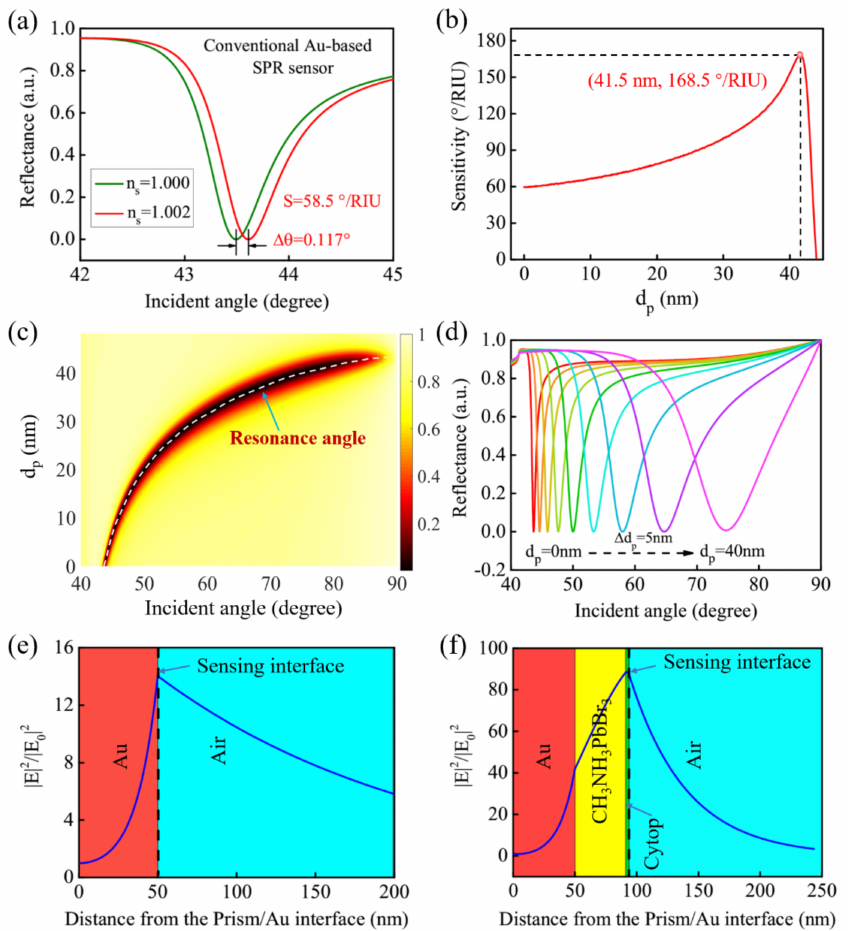
Figure 7. ( a ) SPR signal excited from the conventional SPR gas sensor, and the sensitivity is calculated to be 58.5 ◦ /RIU. ( b ) The sensitivity curve corresponding to different thicknesses of d p for the proposed GWSPR gas sensor, and the highest sensitivity (168.5 ◦ /RIU) is obtained at d p = 41.5 nm. ( c ) The movement of resonance angle corresponding to different thickness of d p . ( d ) The resonance signals excited from the proposed GWSPR gas sensor at different d p . ( e , f ) The electric field distributions of the conventional SPR gas sensor and the new Au-CH 3 NH 3 PbBr 3 -based GWSPR gas